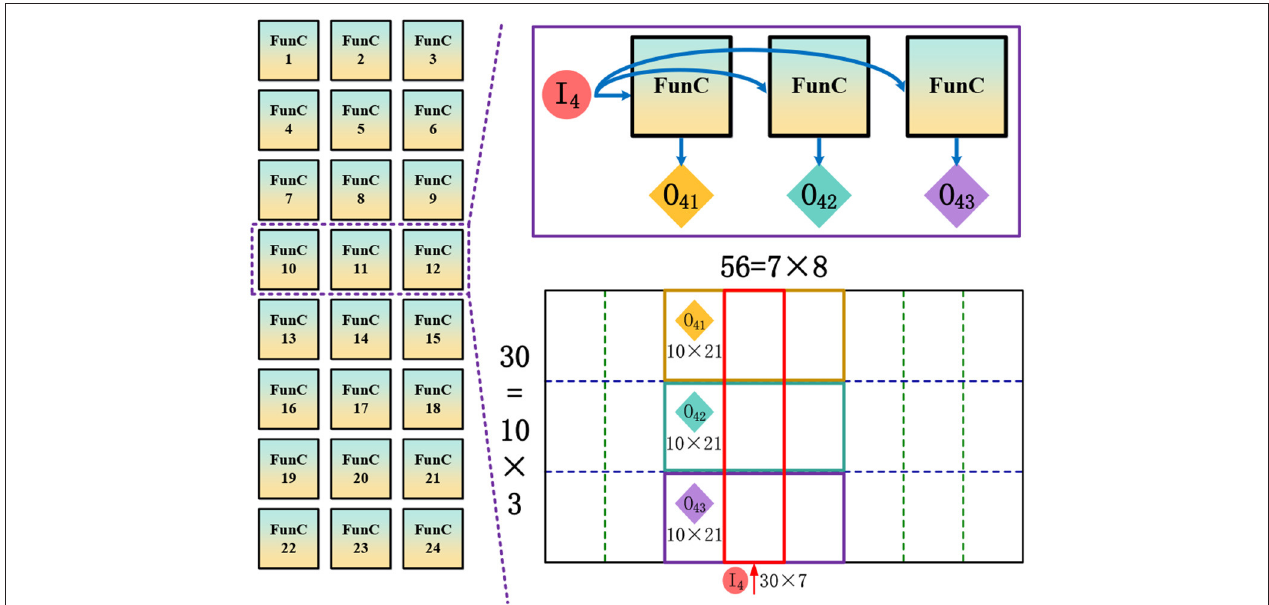
FIGURE 5 | Illustration of the proposed slicing scheme for efficient network mapping.